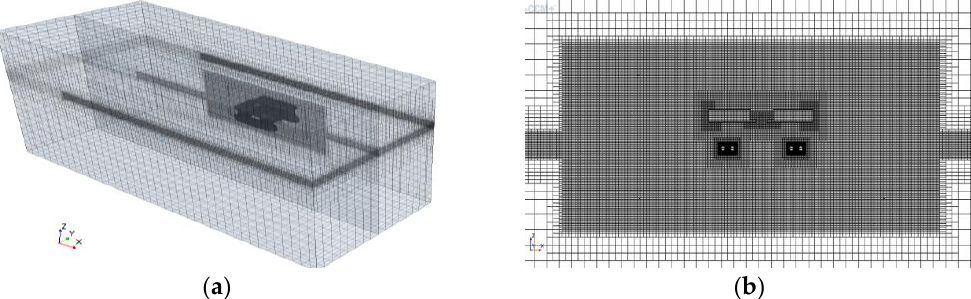
Figure 9. Wave encryption grid and overlapping area grid. ( a ) Wave encryption grid. ( b ) Overlapping area grid.